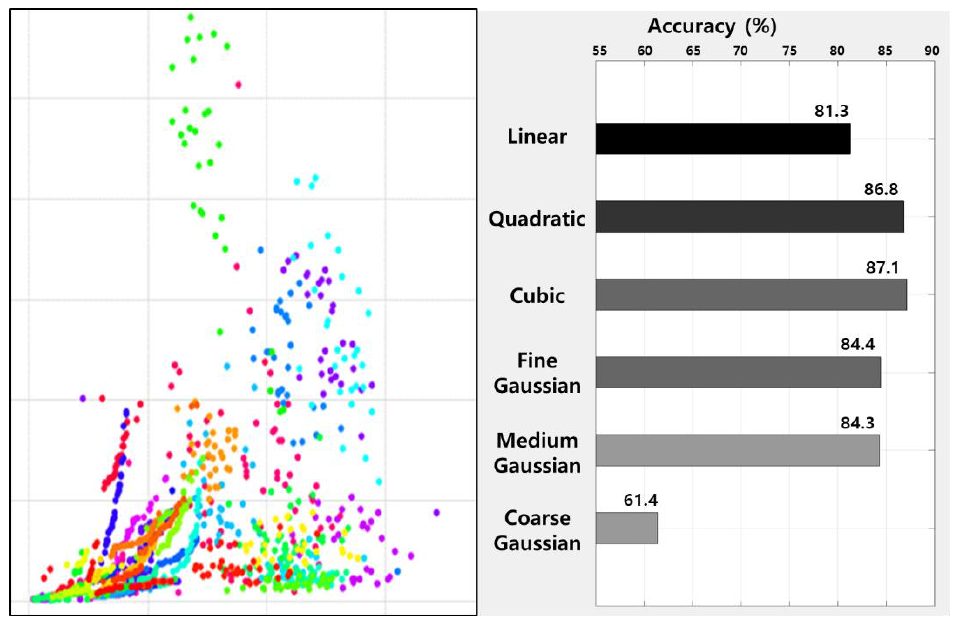
Figure 5. Classification results of EMG signal by using multi-class support vector machine (SVM). The SVM showed an average accuracy of 80.9%, Cubic SVM showed the highest accuracy of 87.1%.